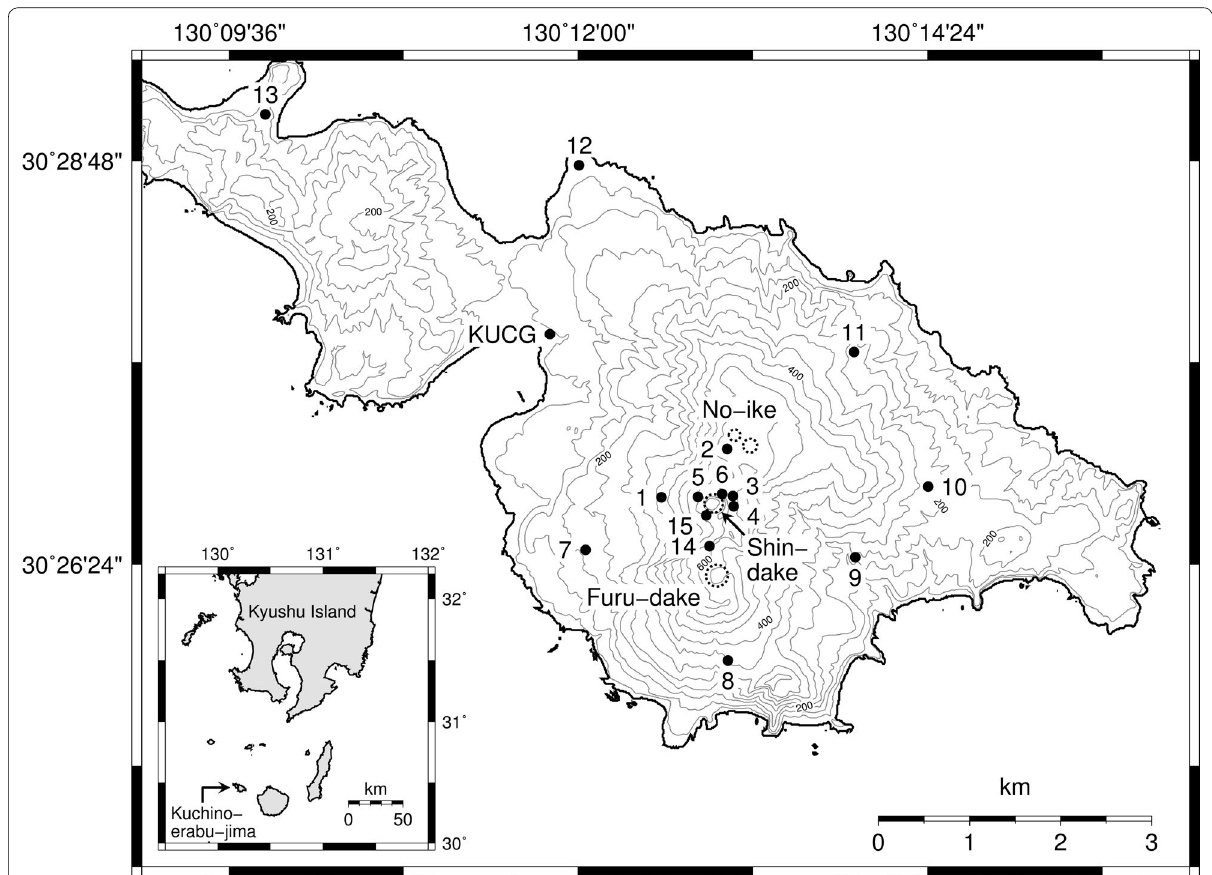
Fig. 1 Location of Kuchinoerabu-jima (bottom left) and distribution of GPS benchmarks (solid circles). Numbers 1–15 are corresponding to KUC1– KUC15, respectively. Circles with dashed lines represent craters of No-ike, Shin-dake, and